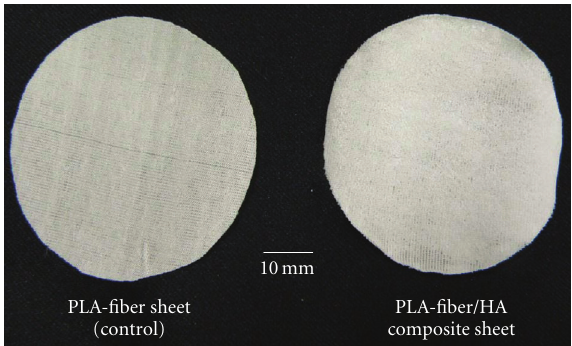
Figure 2: Photograph of the fabricated PLA-fiber/HA composite